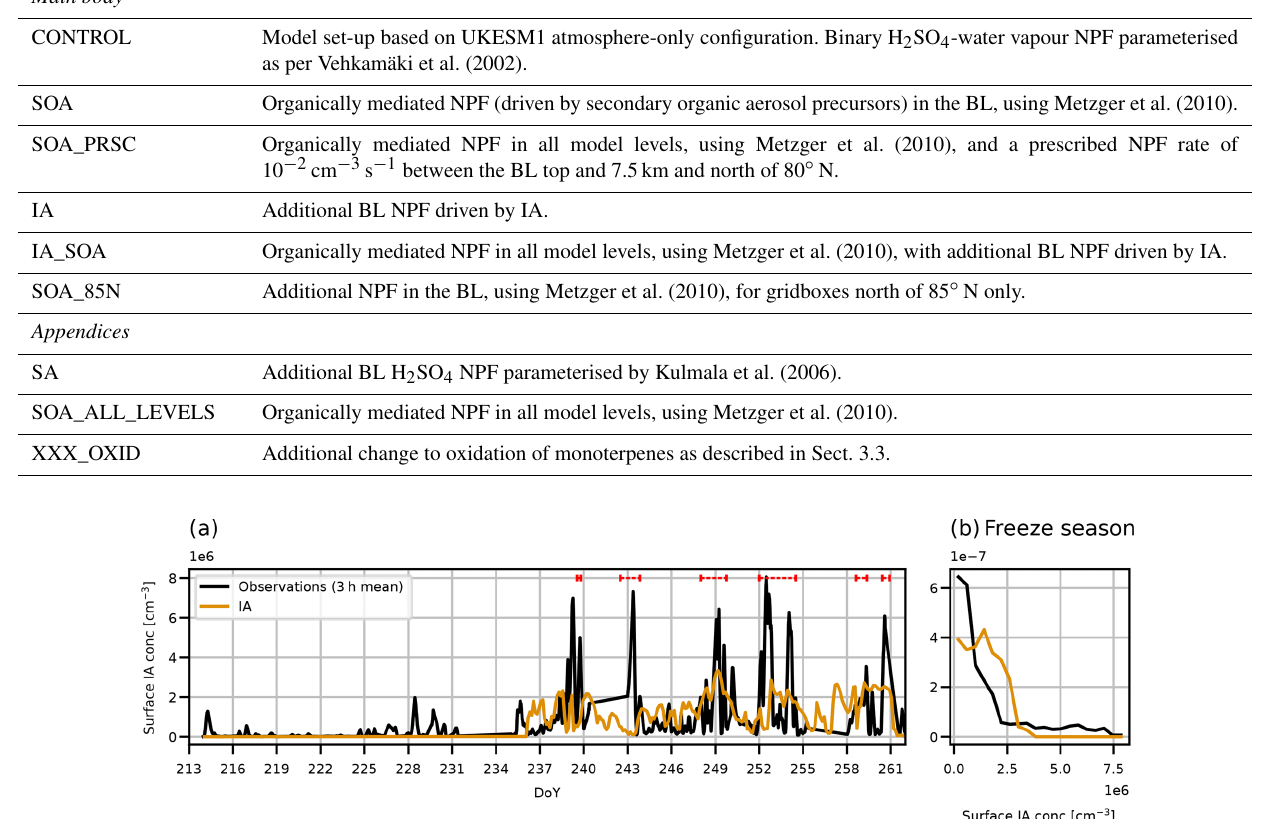
Table 2. Description of simulations. Simulation Description